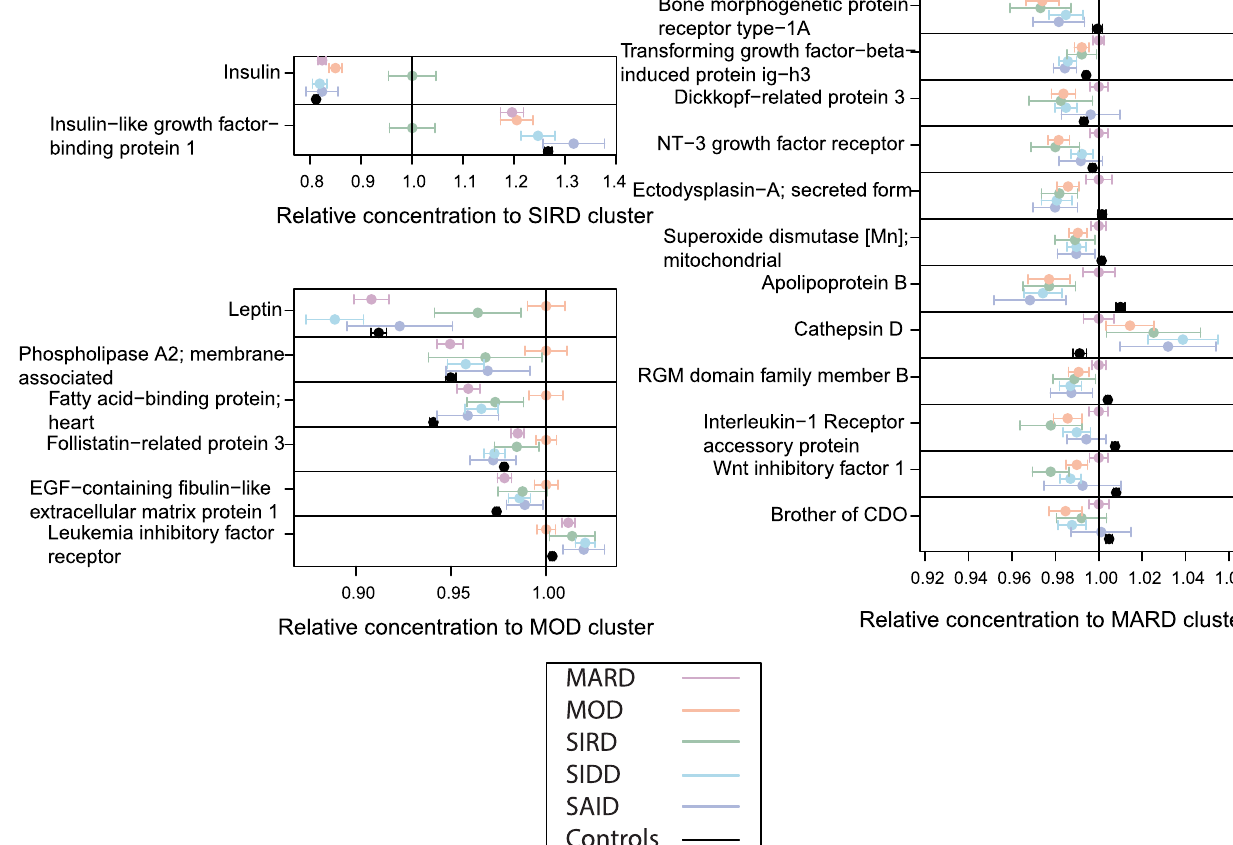
respective reference subtype. In addition, data for SAID and the control group are shownforreference.T2D type2diabetes,SAID severeautoimmune diabetes,SIDD severe insulin-de fi cient diabetes, SIRD severe insulin-resistant diabetes, MOD mild obesity-related diabetes, MARD mild age-related